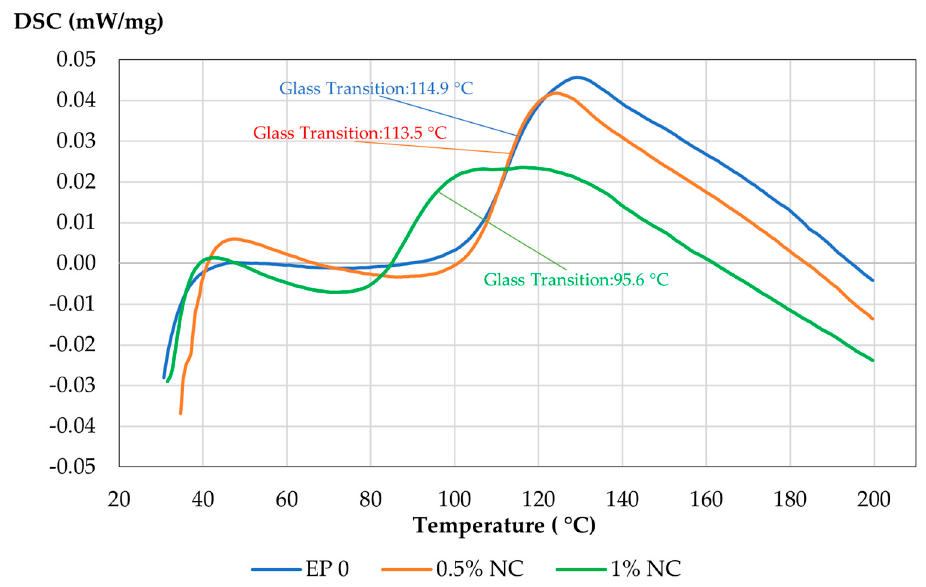
Figure 12. DSC thermogravimetric curves for composites with nanocellulose.